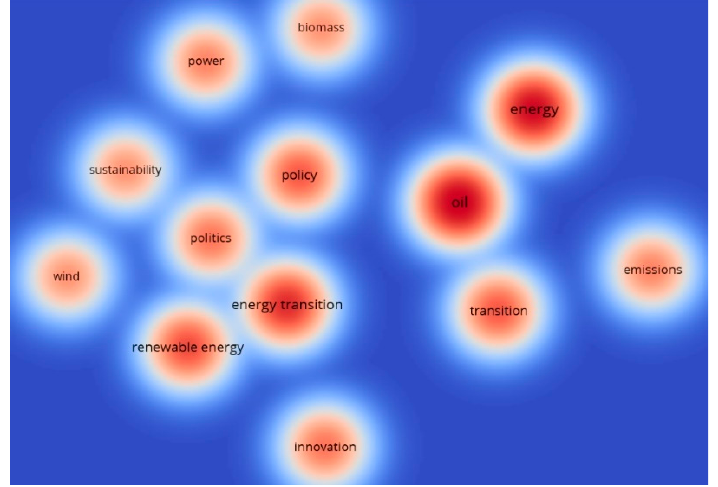
Figure 2. Common words in scientific publications (Source: authors based on WoS’s articles ana ‐ lysed).